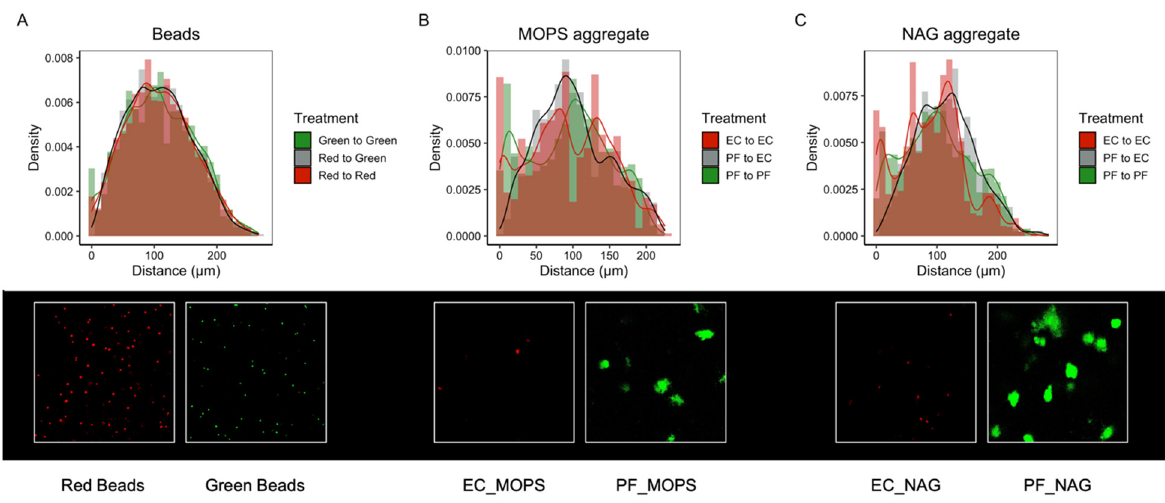
Figure 5. Interaction distances of E. coli RFP (EC) and P. fluorescens GFP (PF) cells within single SSAs compared to 2 µm fluorescent beads. ( A ) Histogram of bead–bead distances in an SSA. ( B ) Histogram of EC and PF interaction distances of cells printed in SSAs with MOPS-only media (MOPS). ( C ) Histogram of EC and PF interaction distances of cells printed in SSAs with MOPS con- taining 4-Methylumbelliferyl N-acetyl- β -D-glucosaminide (NAG), a chitin proxy. In all histograms, red represents EC to EC or red-to-red bead distances, green represents PF to PF or green-to-green bead distances, and gray represents EC to PF or green-to-red bead distances. Representative images are shown below each histogram. All images are 212 µm × 212 µm. Note that color saturation, brightness, and contrast of some images is enhanced for visibility in this figure (see Supplemental Material). EC and PF images and beads are shown as individual channels of the same SSA region.